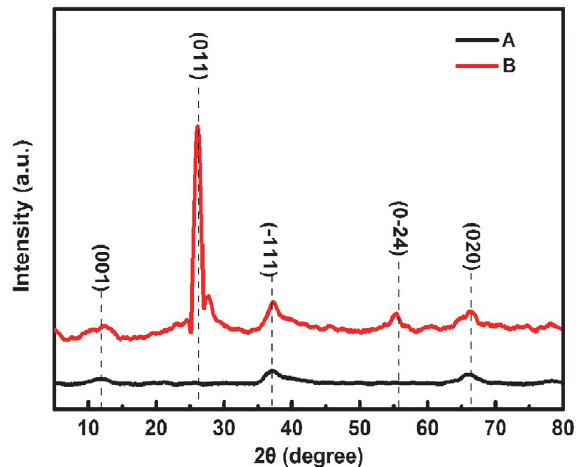
Fig1. XRD patterns of the